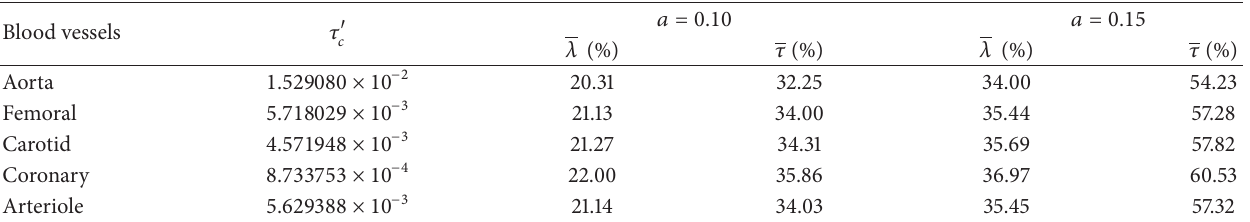
Table 3: Estimates of the percentage of increase in resistance to flow 𝜆 2 and skin friction 𝜏 2 for arteries with different radii with 𝐿 0 /𝐿 = 1 and 𝜏 𝑐 = 0.04dyn cm − 2 .